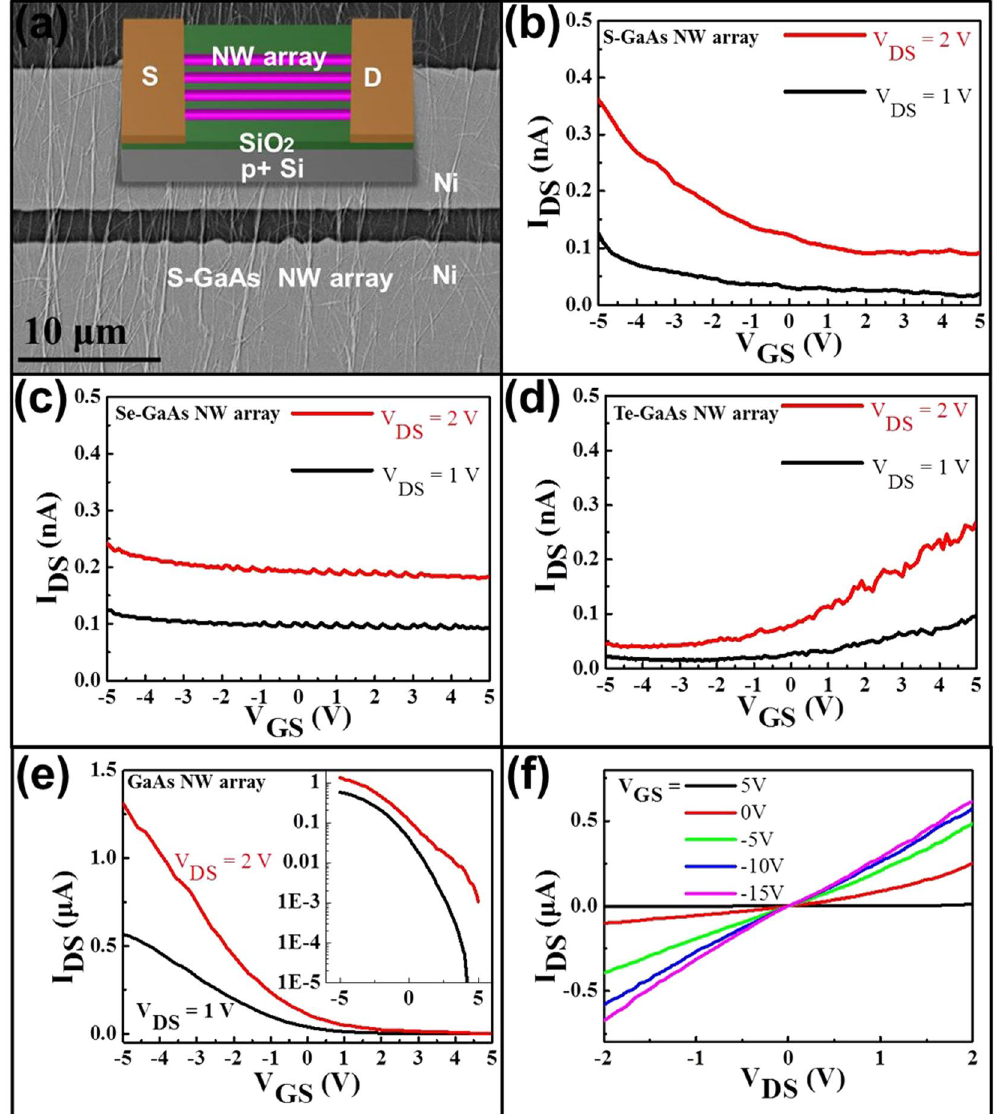
Figure 4. Electrical properties of the as-prepared GaAs NW arrays. ( a ) SEM image of a representative NW arrayed FET with the channel grown with the use of S as the passivator. Inset shows the illustrative device schematic of the parallel arrayed NWFET; ( b – d ) transfer characteristics of parallel arrayed FETs of GaAs NWs prepared by using S, Se and Te as passivators respectively; ( e , f ) are the I DS -V GS and I DS -V DS curves of GaAs NW arrayed FETs, accordingly. The NWs are grown without using any chalcogen passivation but with the similar NW diameter of 20–30 nm employing 2.5 nm thick Au catalyst